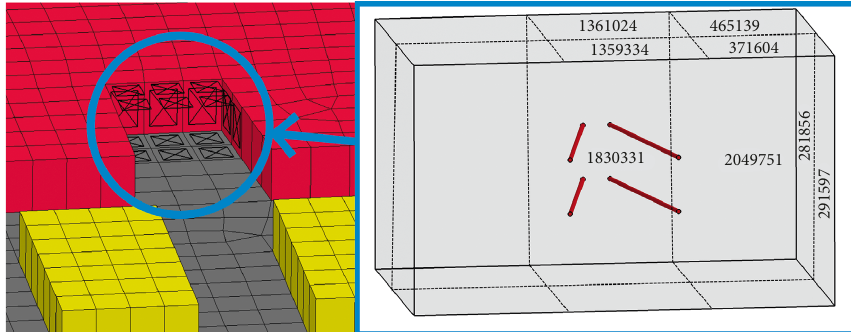
Figure 8: Pressure histories transfer from the segments of the mining face modelled in the local and global approach.